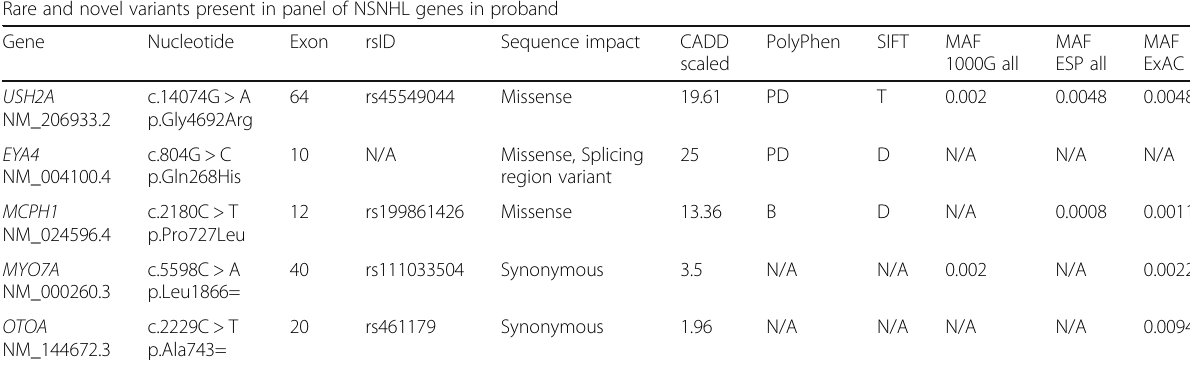
Table 2 Rare and novel variants present in coding regions of 91 genes associated with non-syndromic hereditary hearing loss Rare and novel variants present in panel of NSNHL genes in proband Gene